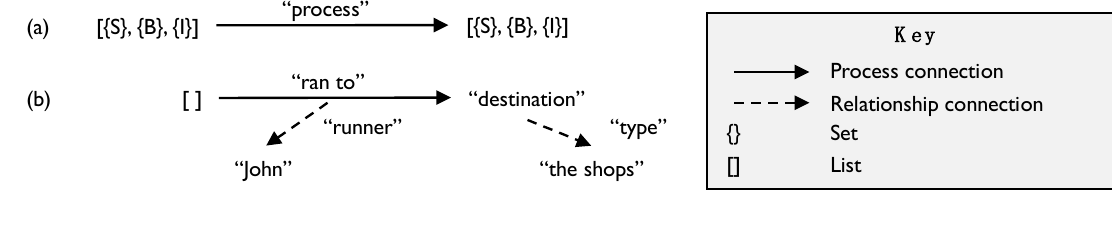
Figure A1. Process Figure A1. Process connections.